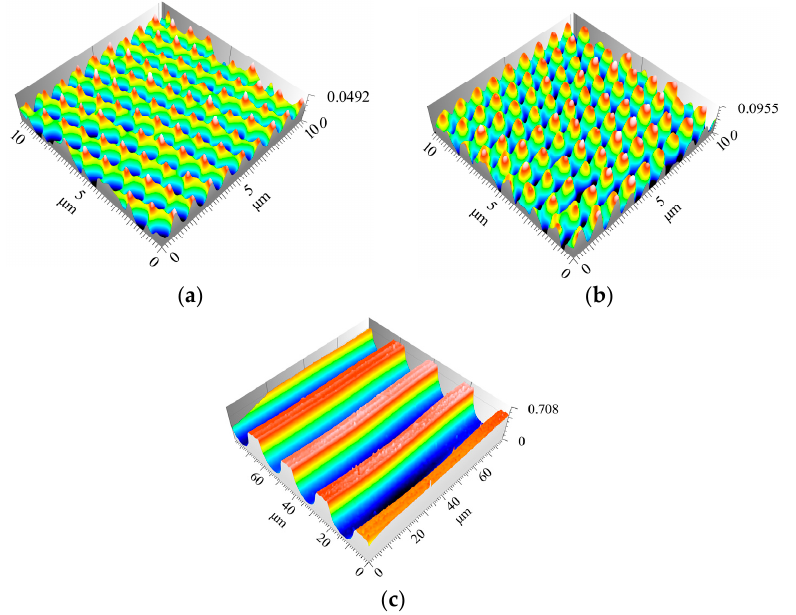
Figure 4. Topography pictures of possible DLIP-Microstructures at 266 nm (ns). ( a ) Two-beam-DLIP; 1 µm periodic cross-like structure ( b ) Three-beam-DLIP; 1.2 µm periodic burl like structure. ( c ) Two-beam-DLIP; 20 µm periodic line-like structure.